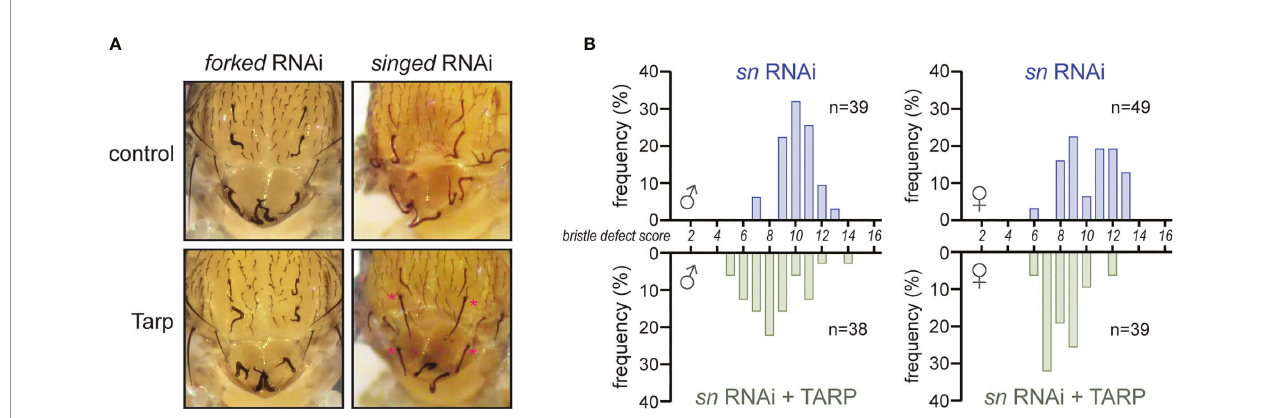
FIGURE 3 | Tarp partially rescues the loss of the host F-actin bundler Singed/Fascin during bristle development. (A) RNAi knockdown of host F-actin bundlers forked and singed result in severe bristle morphology defects. Tarp expression in the singed RNAi background restores bristles to near-normal morphology (asterisks). (B) Histograms of bristle defect scores of male and female fl y populations of singed RNAi knockdown alone (blue bars) or with Tarp expression (green bars). Each fl y was assigned a bristle defect score: ‘ 0 ’ being wildtype; and ‘ 16 ’ as complete and severe defect (see Material and Methods ). There is a leftward shift of bristle defect score distribution in the fl y populations that express tarp in the singed RNAi